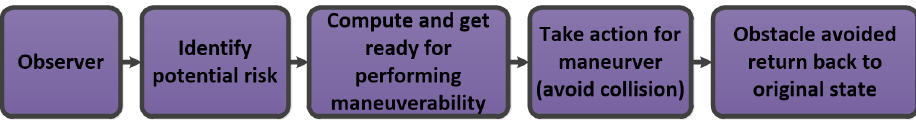
Figure 1. Collision detection steps involve.